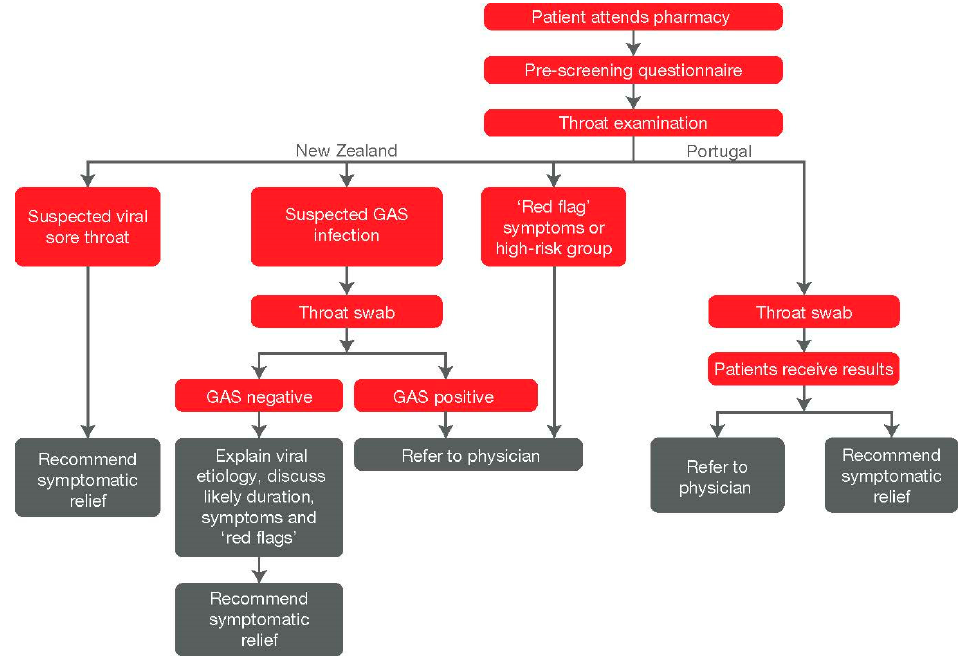
Figure 2. Pharmacy screening process and POC testing intervention in community pharmacies in New Zealand and Portugal. GAS: group A Streptococcus.